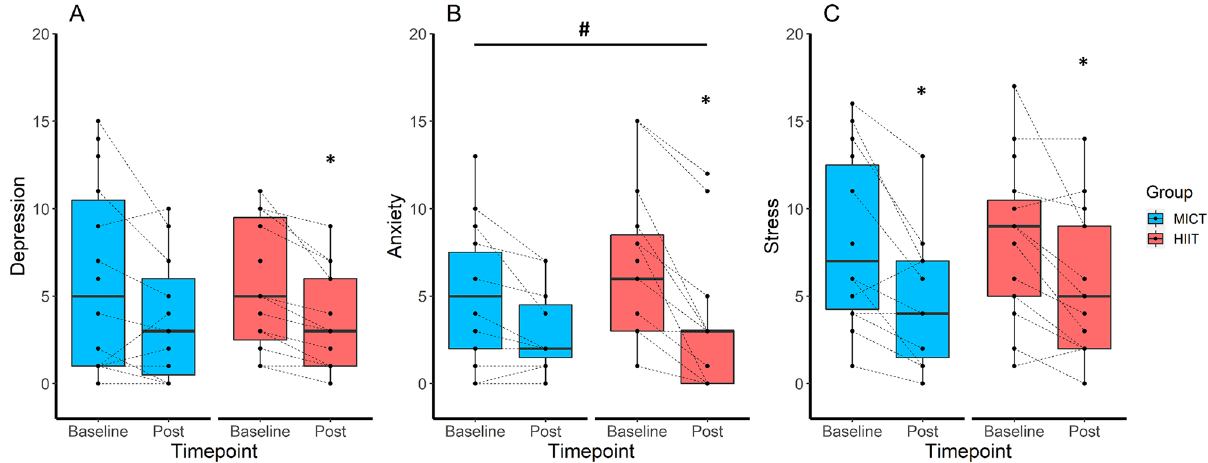
Figure 2. Effect of exercise intensity on depression ( A ), anxiety ( B ) and stress ( C ) scores. Baseline and post- intervention scores, stratified by group and using boxplots showing the median (central line) and 25th to 75th quartiles (box). *Indicates a significant within-group difference P < 0.05, and # indicates a significant between- group difference P <